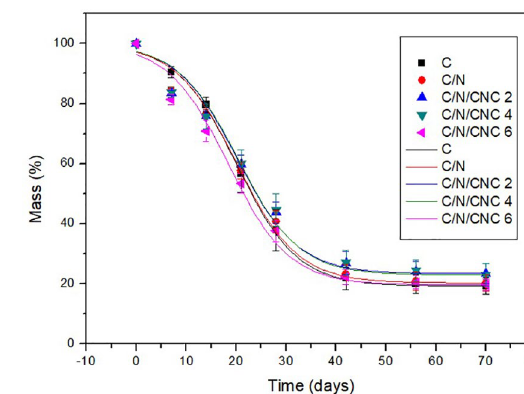
Figure 7. Swelling degree of hydrogels.